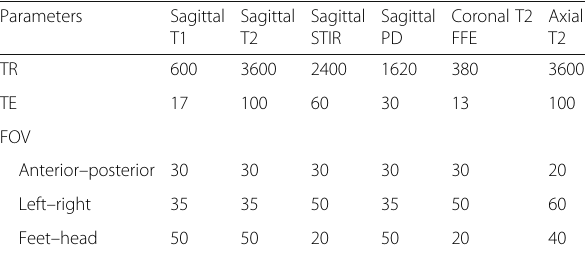
Table 2 Demonstrating the parameters of the MRI